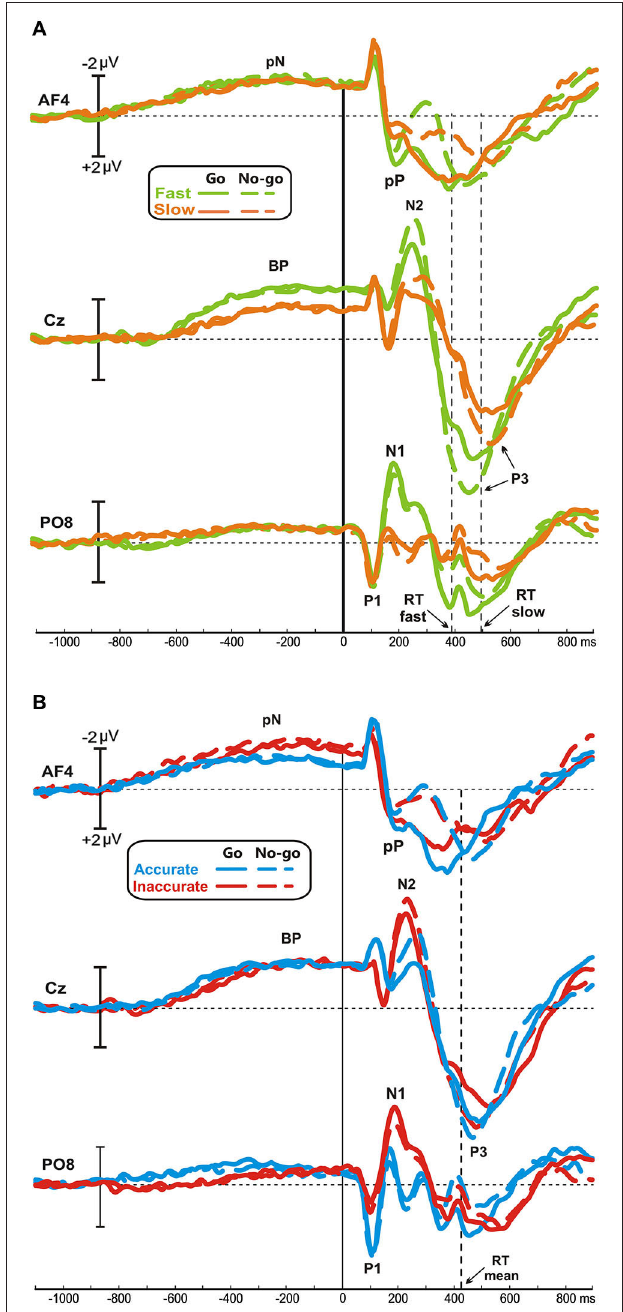
FIGURE 1 | Grand averaged waveforms of Speed- (A) and Accuracy-groups (B) in the three relevant sites (AF4, Cz, PO8); time 0 corresponds to the stimulus onset . The different groups and task conditions are superimposed with different colors. pN, prefrontal negativity; BP,